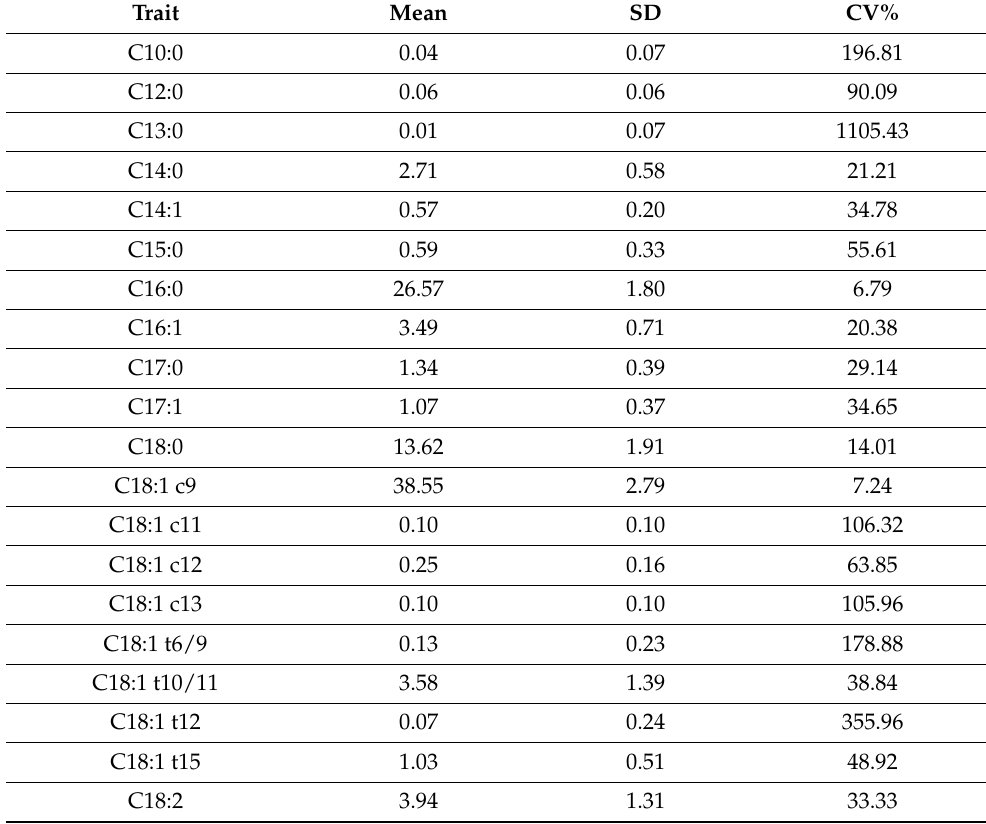
Table 1. Fatty acids and fatty acids groups statistics summary (mean, standard deviation, and coefficient of variance) for all the studied